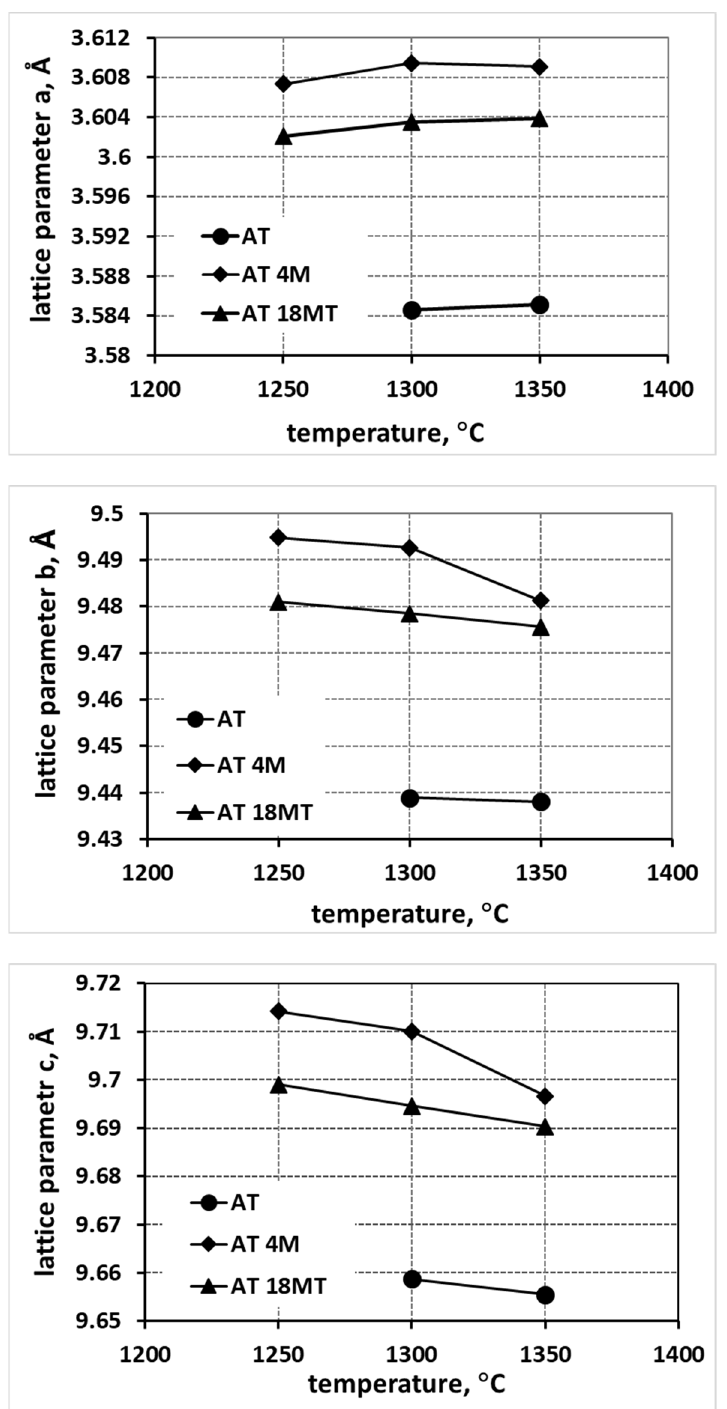
Figure 3. Comparison of changes in lattice parameters of tialite elementary cell and its solid solu- tions in systems stabilized with the same amounts of MgO (AT 4M) and MgTi 2 O 5 (AT 18MT) com- pared with tialite without stabilizers